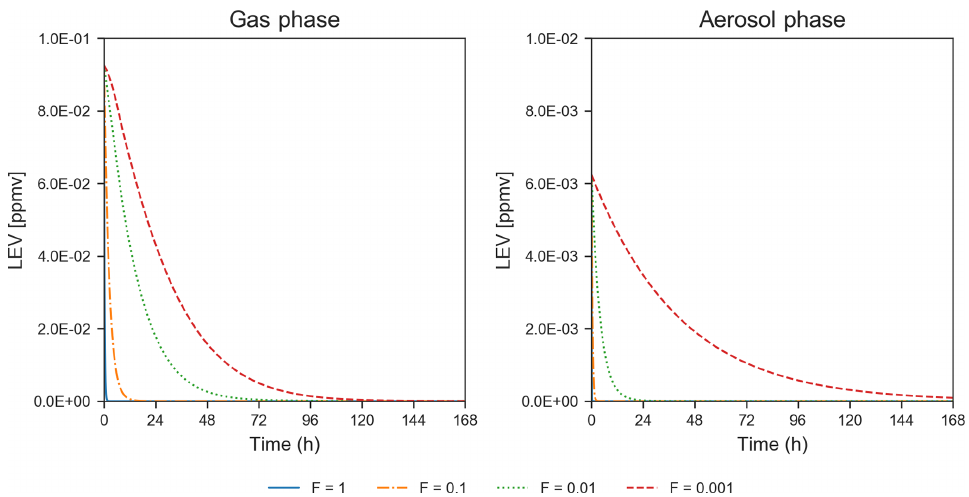
Figure 8. Degradation of LEV by varying the heterogeneous reaction rate coefficient by 4 orders of magnitude, at a constant mass accom- = 13µgm − 3 (conditions from Hennigan et al., 2010). Note that the y axis scale changes between the modation coefficient ( α = 0 . 1) and C ∗ i concentrations presented for the two